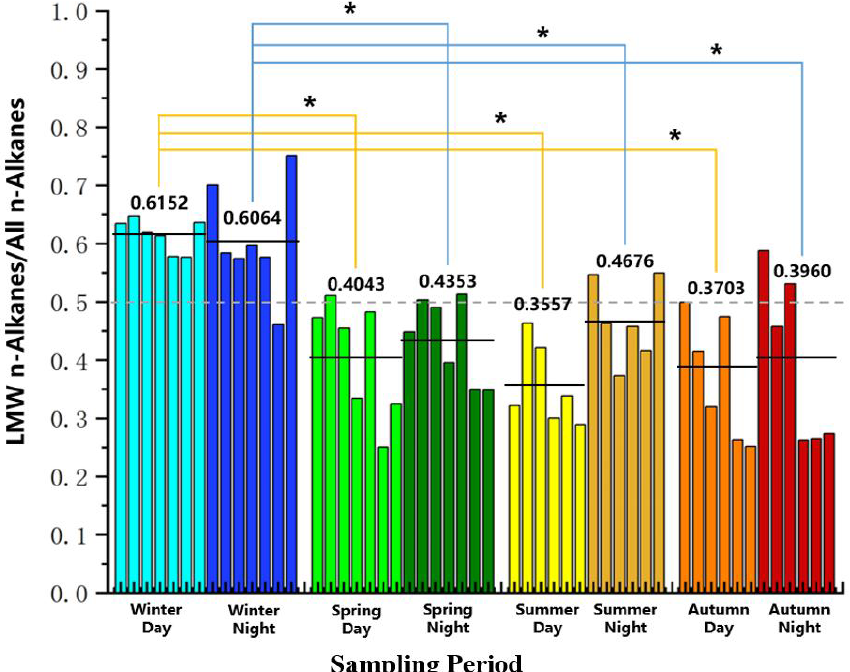
Figure 4. Contributions of low-molecular-weight n -alkanes in the day and night samples in the different seasons of Beijing. ( ∗ indicates a significant difference, the dashed line represents the 50% percentage, and the solid line shows the average proportion of LMW n -alkanes.)